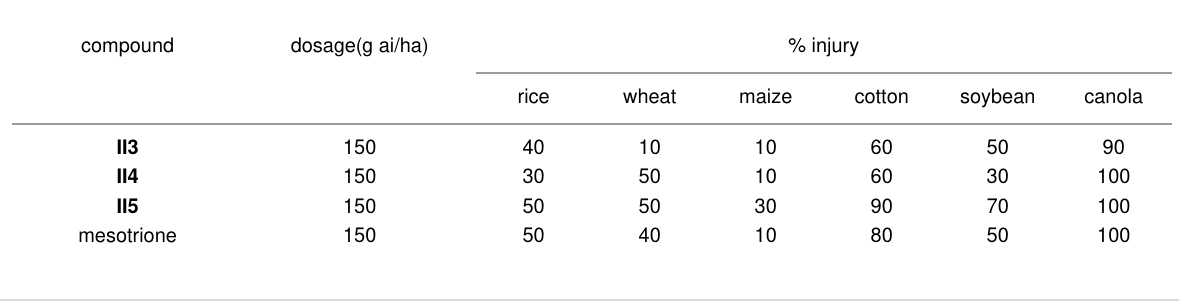
Table 3: Postemergence crop safety of compounds II3 , II4 and II5 (150 g ai/ha).